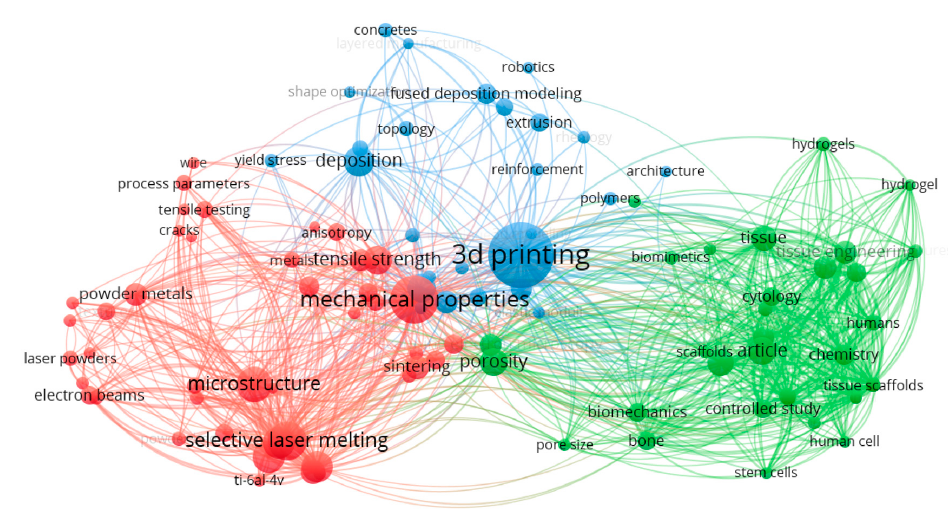
Figure 3. Co-occurrence analytical map of keywords generated based on Scopus data set. Note: the minimum cluster of 40 is considered and three clusters include 109 keywords among 2321 papers.